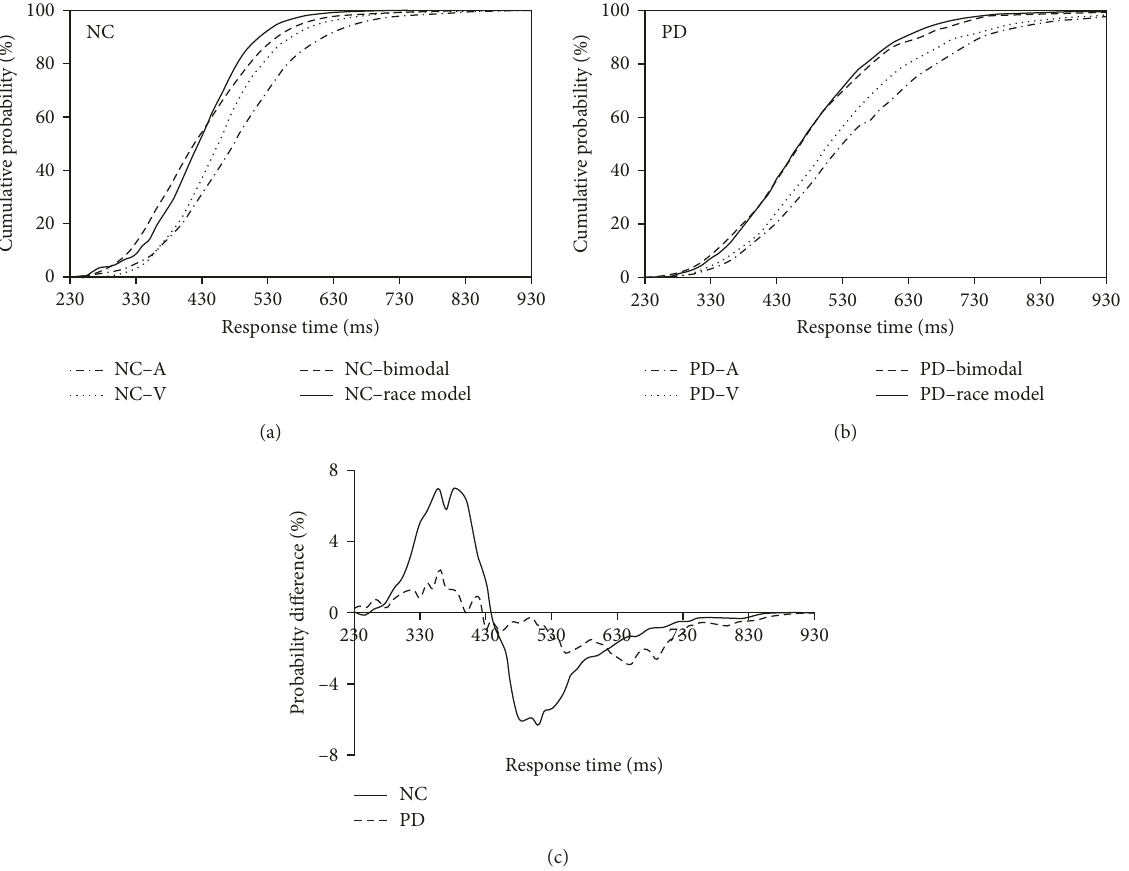
Figure 3: Distributions of response times. (a) Cumulative distribution functions (CDFs) for the discrimination response times to auditory, visual, and audiovisual stimuli and for the race model for NC. (b) CDFs for PD. (c) Significant audiovisual integration was found in NC (solid line), but not in PD patients (dotted line).